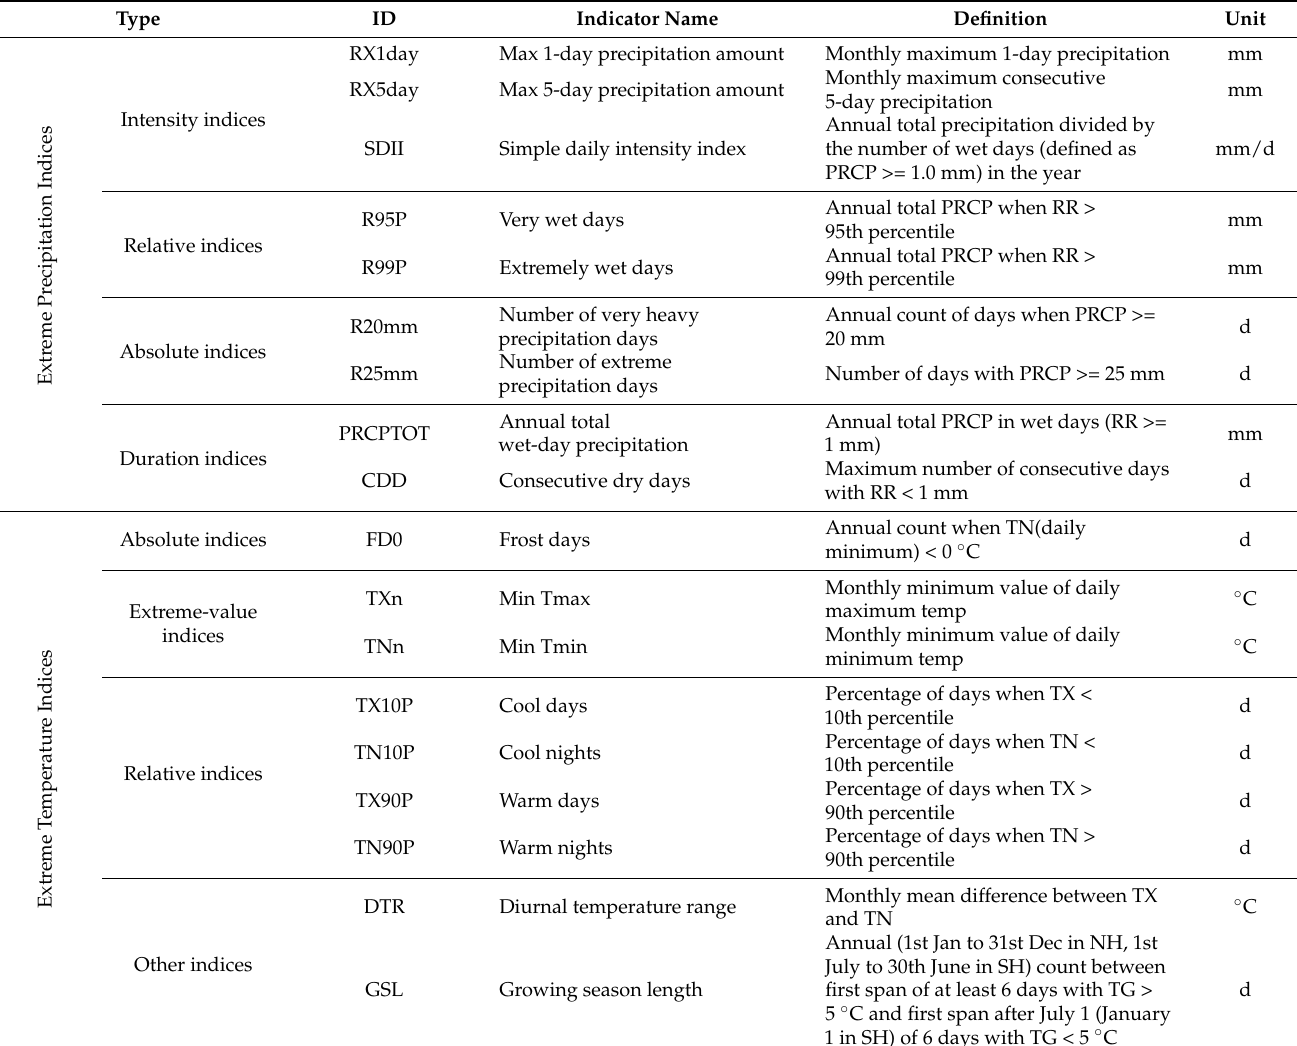
Table 1. Selection of extreme climate indices in this